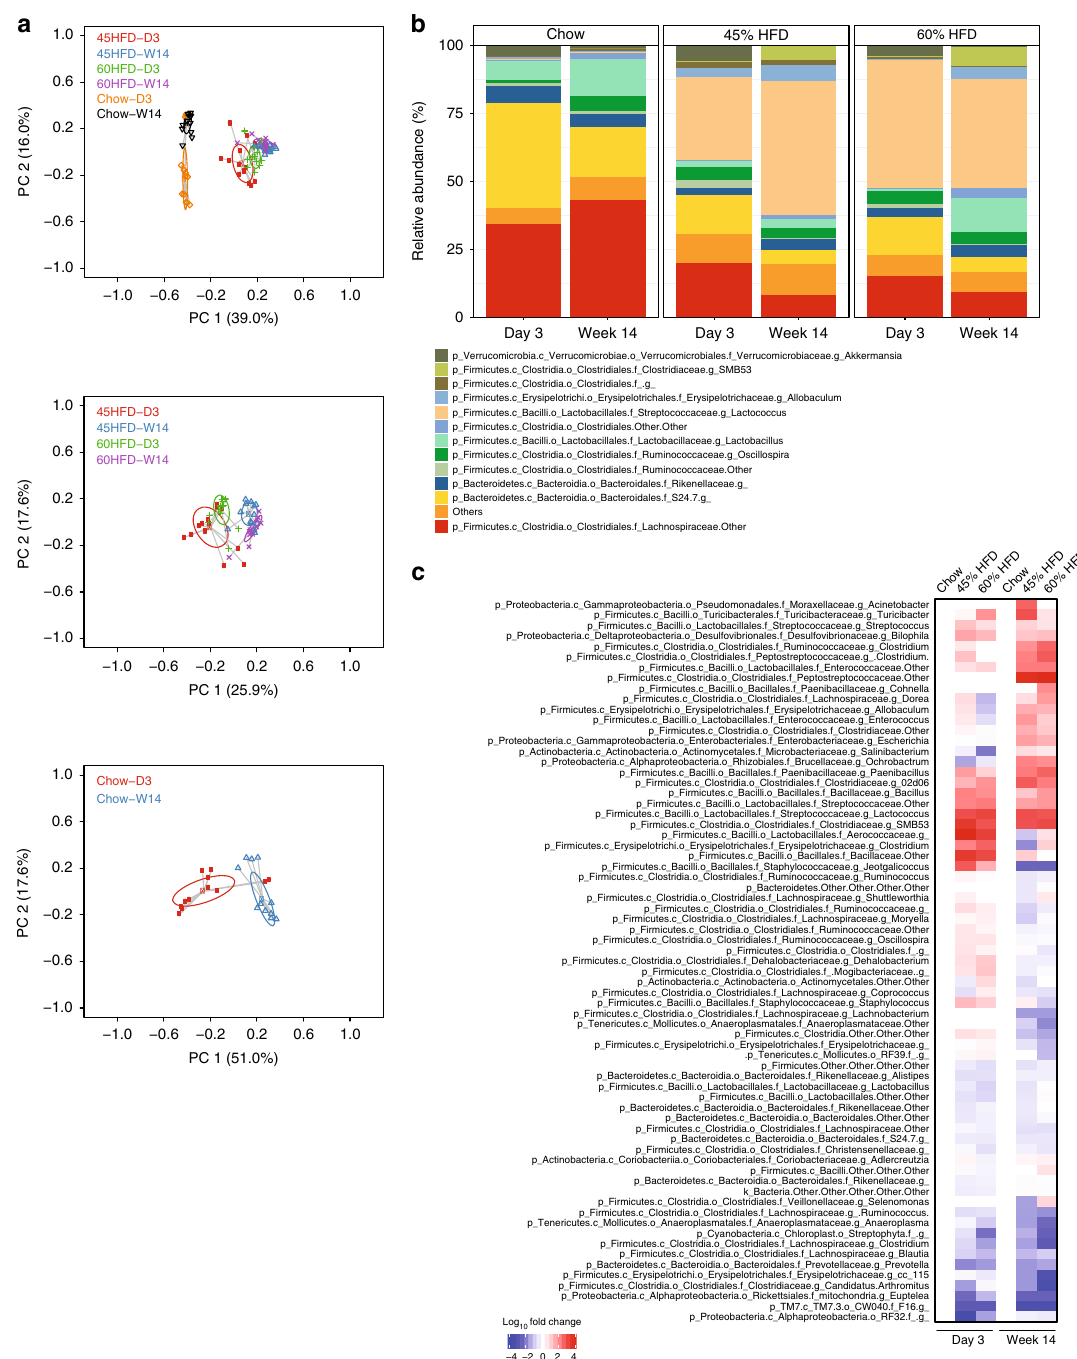
Fig. 3 Rapid changes in the composition of the fecal microbiota are maintained during prolonged obesogenic diet feeding. Fecal samples were taken 3 days (D3) and at 14 weeks (W14) after feeding chow or each obesogenic diet and processed for bacterial DNA sequencing (Chow = 12, 45% HFD = 13, 60% HFD = 12 mice). a PCoA of Bray-Curtis dissimilarity between each of the 3 diet groups (Day 3 and Week 14) (top panel), between the two obesogenic diet groups only (Day 3 and Week 14) (middle panel), and between Day 3 and Week 14 of mice that only ate the chow diet (bottom panel). b Stacked bar graph showing the relative abundance of the 12 most abundant bacterial taxa (Genus level) at Day 3 and Week 14 mice fed each diet. c Heat map of the 69 microbial taxa that differed between mice fed Chow, 45% HFD, and 60% HFD on Day 3 or Week 14. The average relative abundances of each taxon detected in mice fed the respective diets for 3 days or 14 weeks were compared between groups. For each time point (Day 3 or Week 14), non-parametric analysis of variance for each taxon between the diet groups was conducted using the Kruskal – Wallis test. Taxa that passed the signi fi cance threshold of p < 0.05 were analyzed using the pairwise Wilcoxon rank sum test. Correction for multiple hypothesis testing (FDR) was calculated using the Benjamini- Hochberg method. Statistical signi fi cance was accepted at p < 0.05. Fold change in relative abundance of the taxa that signi fi cantly changed between the groups was expressed relative to Chow within each timepoint and plotted in the